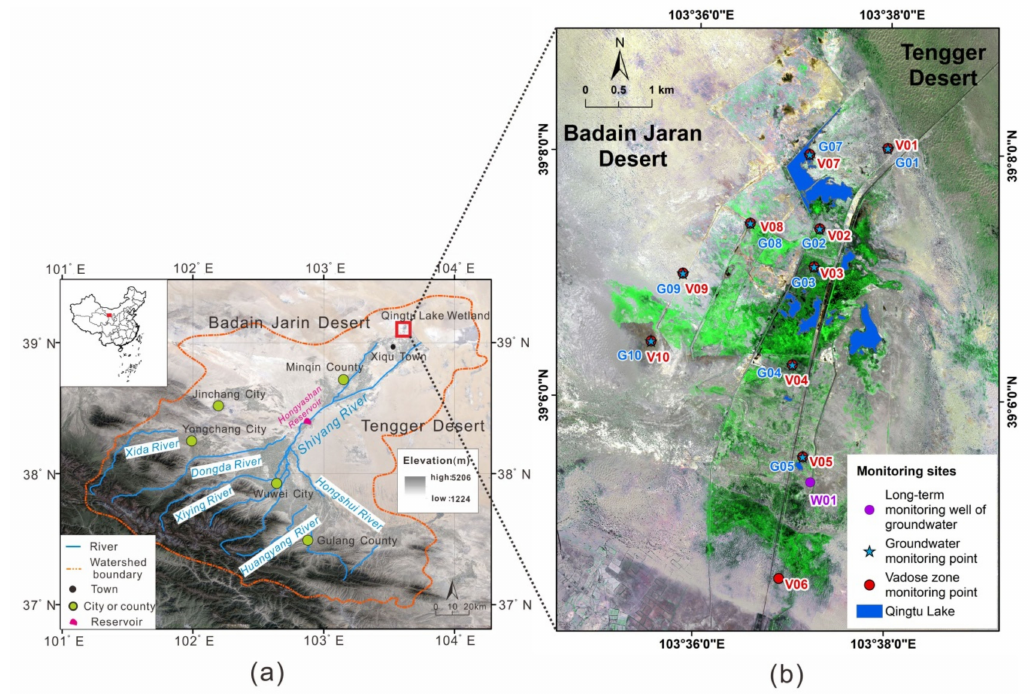
Figure 1. Location of the study area ( a ) and monitoring locations in the Qingtu Lake wetland ( b